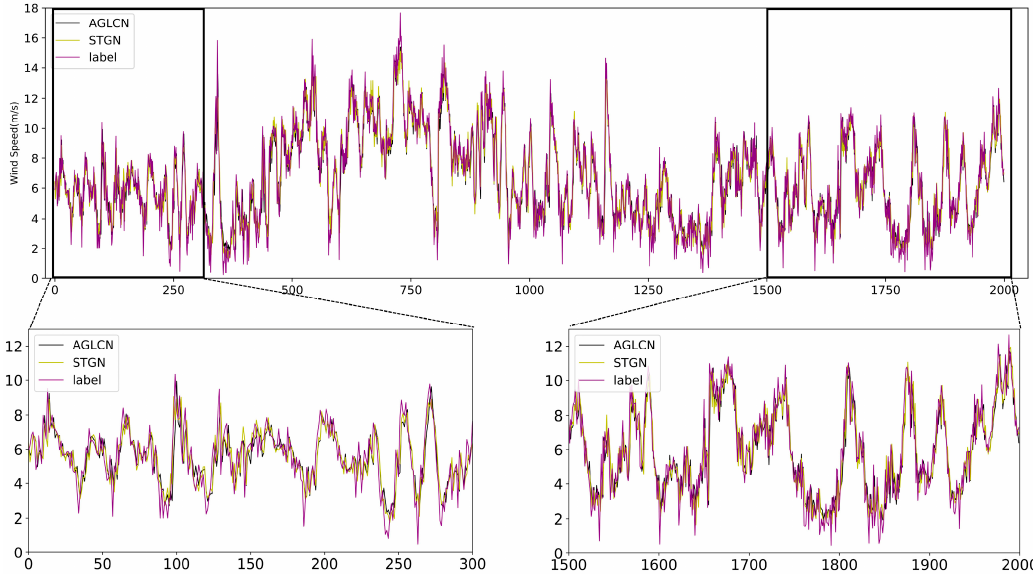
Figure A4. Comparison of the predicted results for wind speed at Point 1.